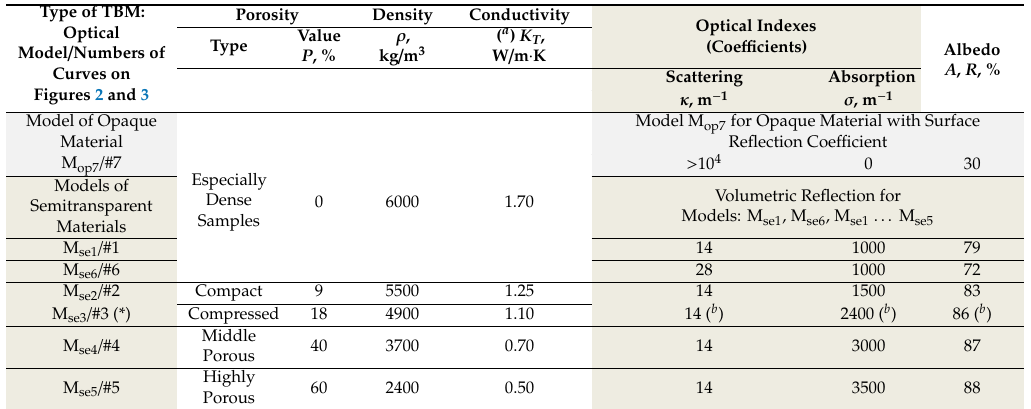
Table 2. Optical, thermal and structural characteristics for model & experimental (*) samples of opaque (semitransparent) ceramics based on yttria partially stabilized zirconium dioxide (PSZ) ZrO 2 + 8%Y 2 O 3 versus its